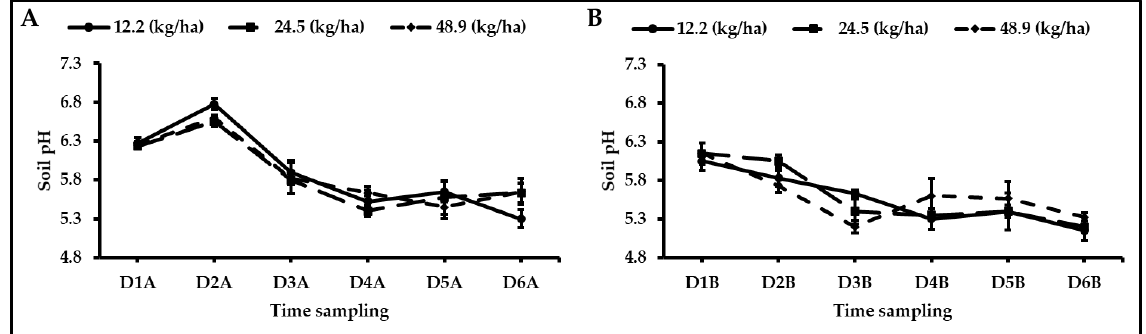
Figure 3. Soil pH of two farms (Farm ( A ); Farm ( B )) with different P fertilizer application rates (0 kg P ha −1 ; 24.5 kg P ha −1 ; and 48.9 kg P ha −1 ) in the year 2018. Each D represents a date: D1A = 4 January 2018; D2A = 22 February 2018; D3A = 7 March 2018; D4A = 23 March 2018; D5A = 12 April 2018; D6A = 26 April 2018; D1B = 12 December 2017; D2B = 5 February 2018; D3B = 7 March 2018; D4B = 23 March 2018; D5B = 12 April 2018; and D6B = 30 April 2018. Error bars exhibit the standard error of the mean from four replicates of the measurements.